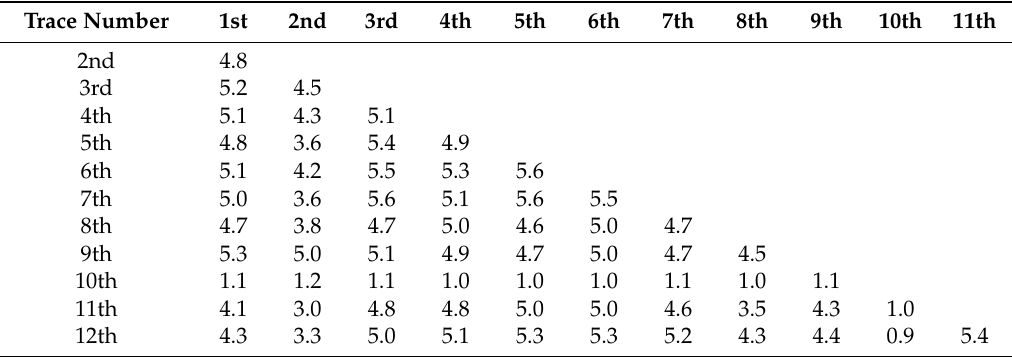
Table 5. The peak values (×10 − 4 ) of the phase-only correlation (Wigner-Ville distribution) (POC (WVD)) for all pairs of traces.